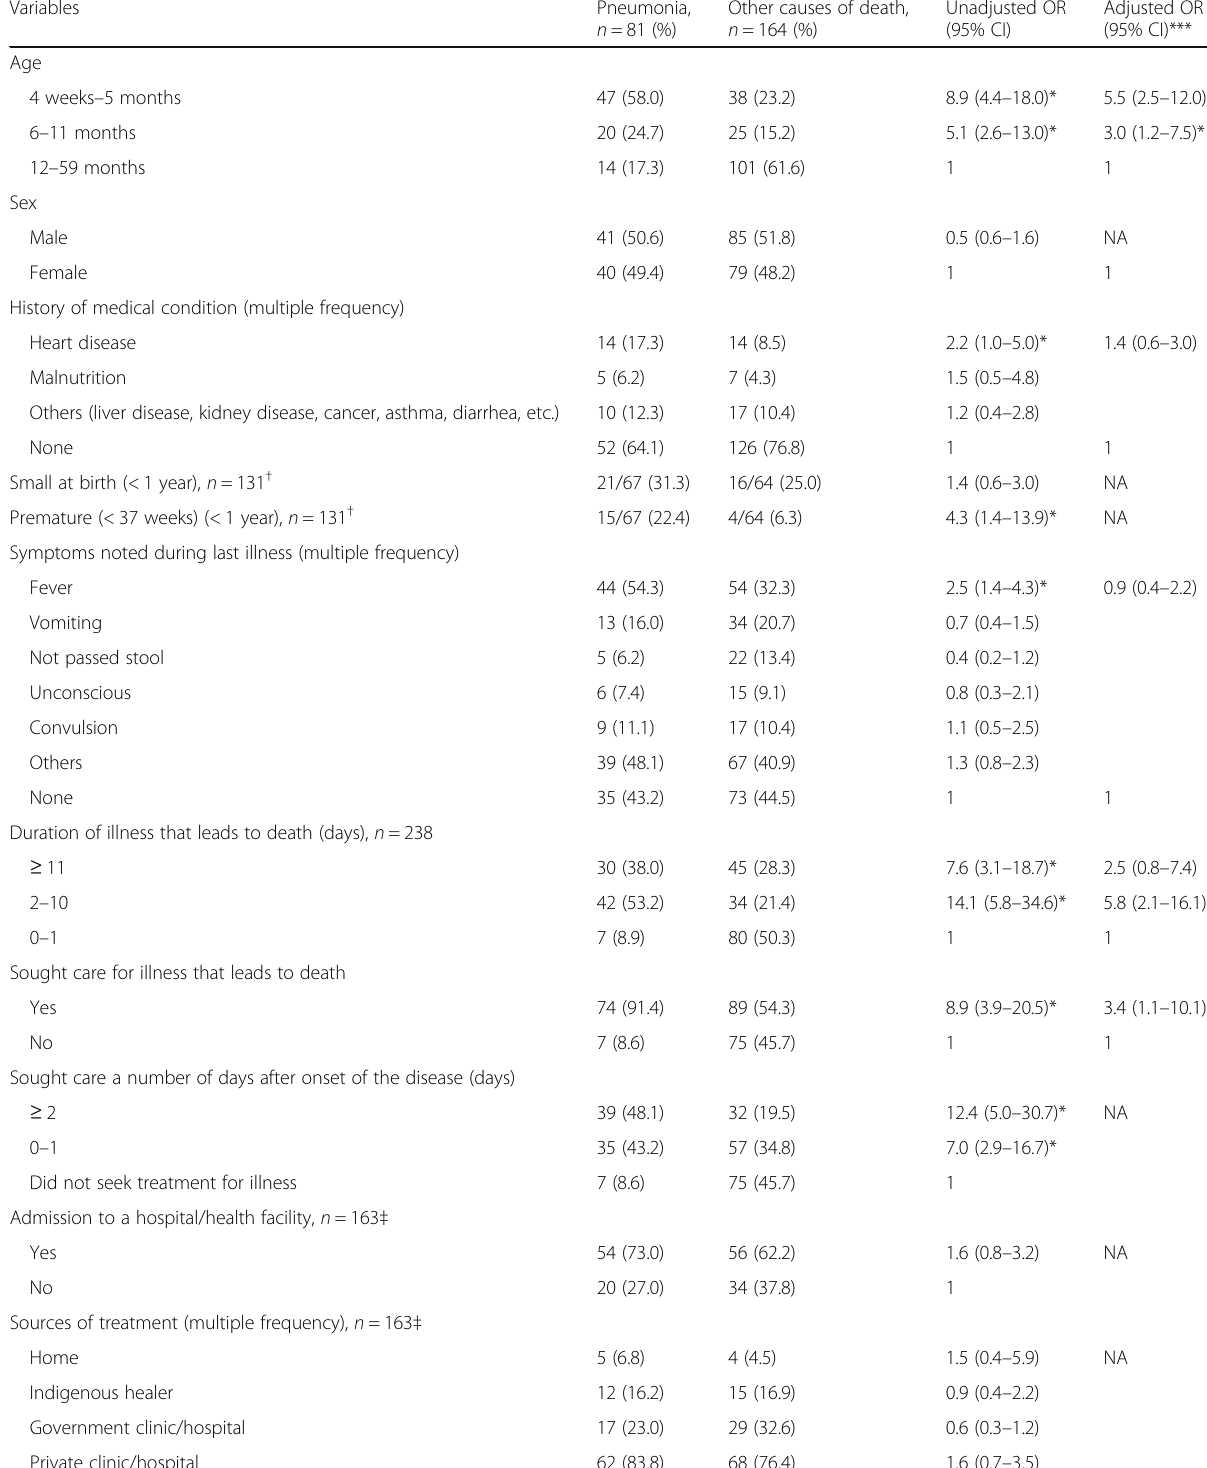
Table 2 Correlates of pneumonia deaths compared to other causes of deaths in children aged 4 weeks to 59 months in rural Bangladesh ( n =